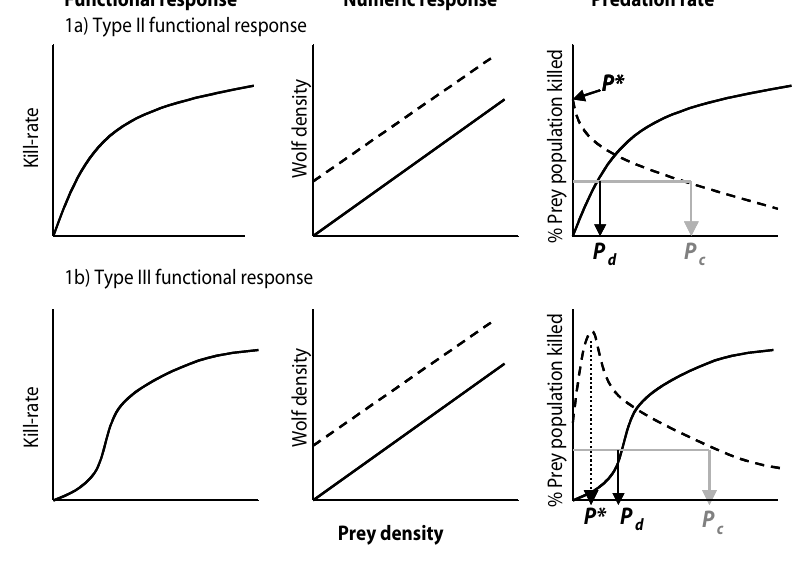
Fig. 1. Functional responses, numeric responses, and predation rates for a) type II and b) type III functional responses with (dashed line) and without (solid line) a numeric response with a Y-intercept, for a multiple prey system. For a given predation rate, some prey populations have a critical density below which their population will decline to extinction. Without a Y-intercept, the prey population is regulated to some low density, Pd , for a given critical % mortality rate (grey line). In the presence of a Y-intercept, however, predation rate is inversely density dependent, and for a given critical % mortality rate, Pc , prey density P* declines to extinction under type II functional response, or a very low density in the presence of a type III functional response. Adapted from Messier (1994, 1995) and Dale et al .